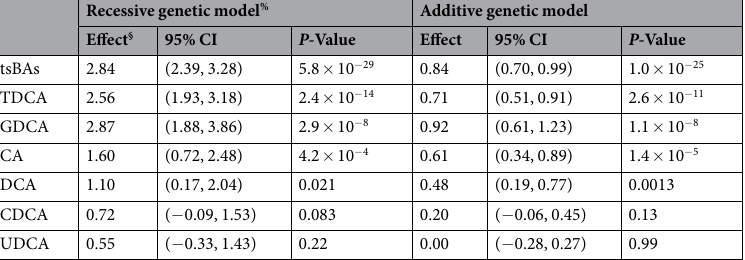
Table 2. Statistical analyses of total serum bile acids (tsBAs) and six BA species for association with p.Ser267Phe genotype in SLC10A1 # . # tsBAs: total serum bile acids. TDCA: taurodeoxycholic acid. GDCA: glycodeoxycholic acid. CA: cholic acid. DCA: deoxycholic acid. CDCA: chenodeoxycholic acid. UDCA: ursodeoxycholic acid. CI: confidence interval. The P -values were obtained from separate linear regressions for each log-bile acid (BA) per genotype and for the total serum BAs (tsBAs), adjusted for age and gender. Our threshold for declaring significance is P = 0.05/14 = 0.0036. % Recessive genetic model: for these linear regressions, the wild-type and heterozygous individuals were pooled and compared to the homozygous individuals. § Mean change in log-bile acid associated with having the homozygous mutation under the recessive models, or with each extra mutation under the additive models. Under both models a negative effect indicates the mutation is associated with a reduction in the bile acid, and a positive effect is an increase in tsBAs or BA species.